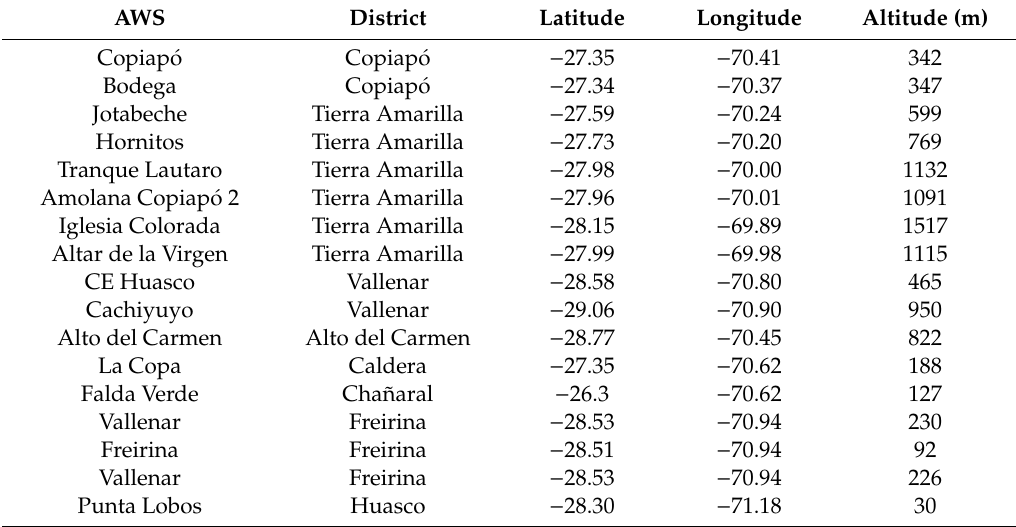
Table 2. Automatic weather station (AWS) locations in the National Meteorological Network (NMN), which was installed in the Atacama region, and was used for influence-area estimation, according to topoclimatic